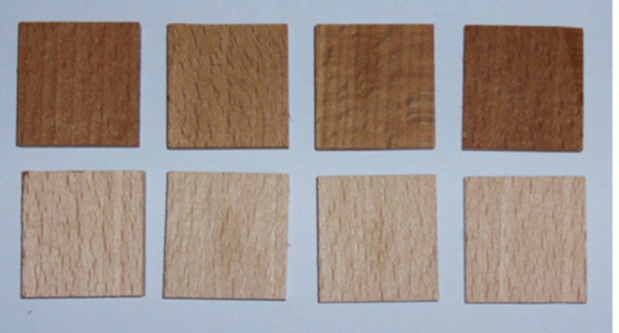
Figure 3. Samples of modified ( first row ) and unmodified beech wood ( second row